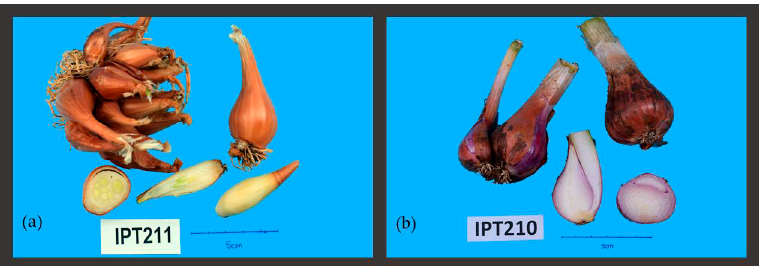
Figure 2. Shallot species : A. × cornutum ( a ) and A. × proliferum ( b ) cluster and bulb images. The number in the figure represents the accession code assigned in the ex situ collection at IPTPO.